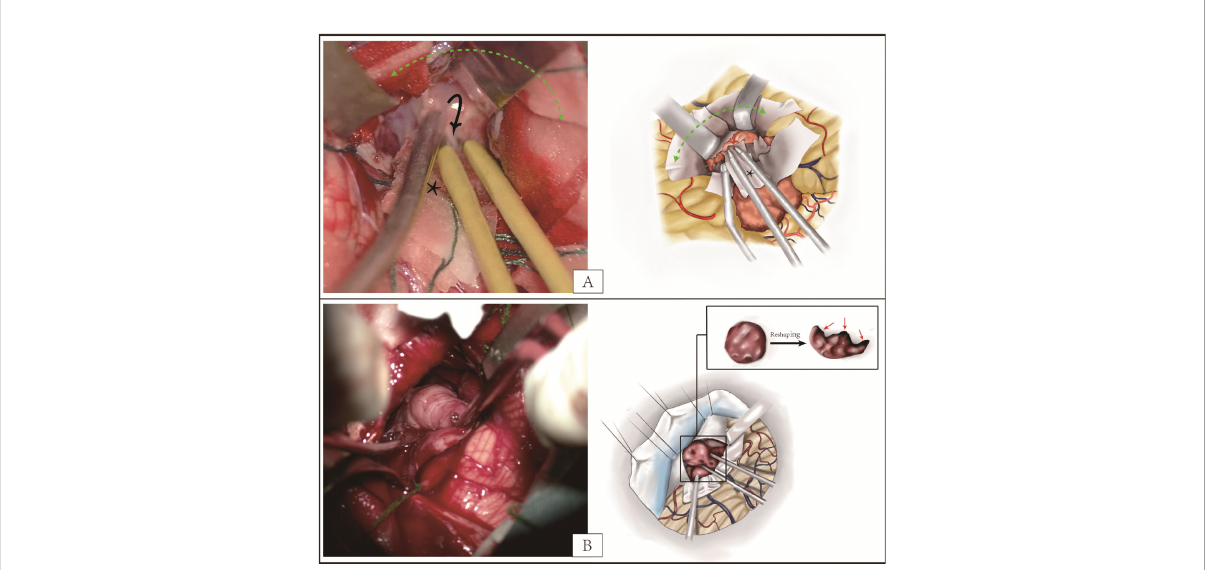
FIGURE 5 (A) The exposure of ependymoma in the posterior fossa. The “ tumor-side ” manipulation (black arrow) can avoid the excessive stretch on adjacent parenchyma when exposing the deep feeding vessels. The cottonoids strip (black asterisk) can serve as a screen between tumor and bipolar coagulation to reduce super fi cial contact hemorrhage and tumor implantation mediated by iatrogenic operation. According to the “ non- touching ” principle from en bloc concept, more cottonoids strips (blue asterisk) are advocated for reduction of tumor seeding in addition to protection of cerebellum. (B) The reshaping of tumor by bipolar coagulation for deep exposure or extraction resulting from limited incision. Different from the piecemeal resection or reshaping by micro-forceps, reshaping by bipolar coagulation can maximal the integrity of lesion to reduce the tumor cell spreading and hyperthermia inactivation of cut section (red arrow), which comes from the “ taking as a whole ” principle of en bloc